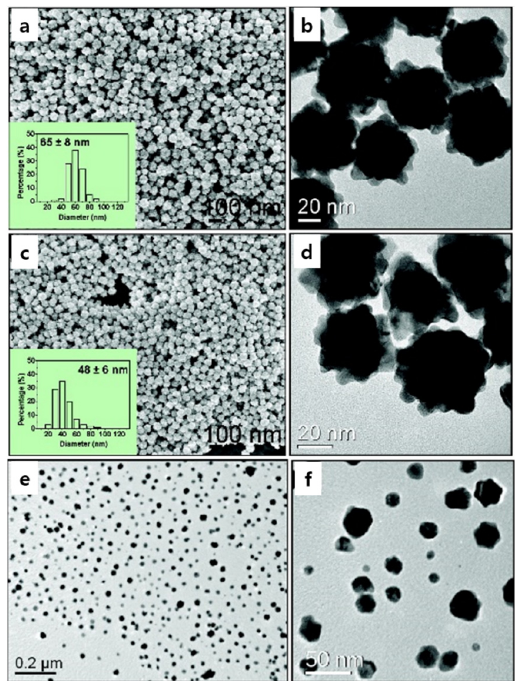
Figure 4. Representative FE–SEM and TEM images of Au nanocrystals formed by reducing aqueous AuCl 4 – solution (0.5 mM) with HEPES solutions of different concentrations: ( a , b ) 15 mM; ( c , d ) 20 mM; ( e , f ) 40 mM. The insets in ( a , c ) show the histograms of the size distribution of the as-synthesized Au nanoflowers. Reprinted with permission from Ref. [52]. Copyright 2008, American Chemical Society.